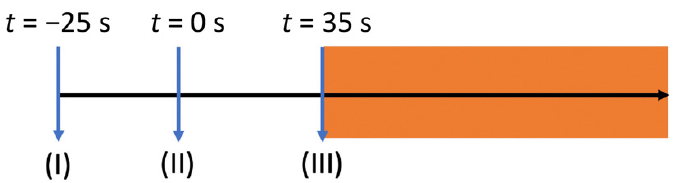
Figure 2. A schematic plot of the delivery timeline of hyperpolarized [1- 13 C]pyruvate. Three stages